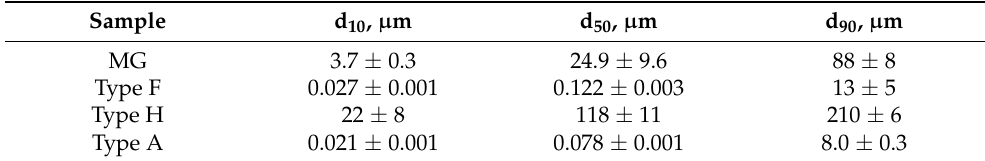
Table 2. Particle size characterization of gypsum CDW.